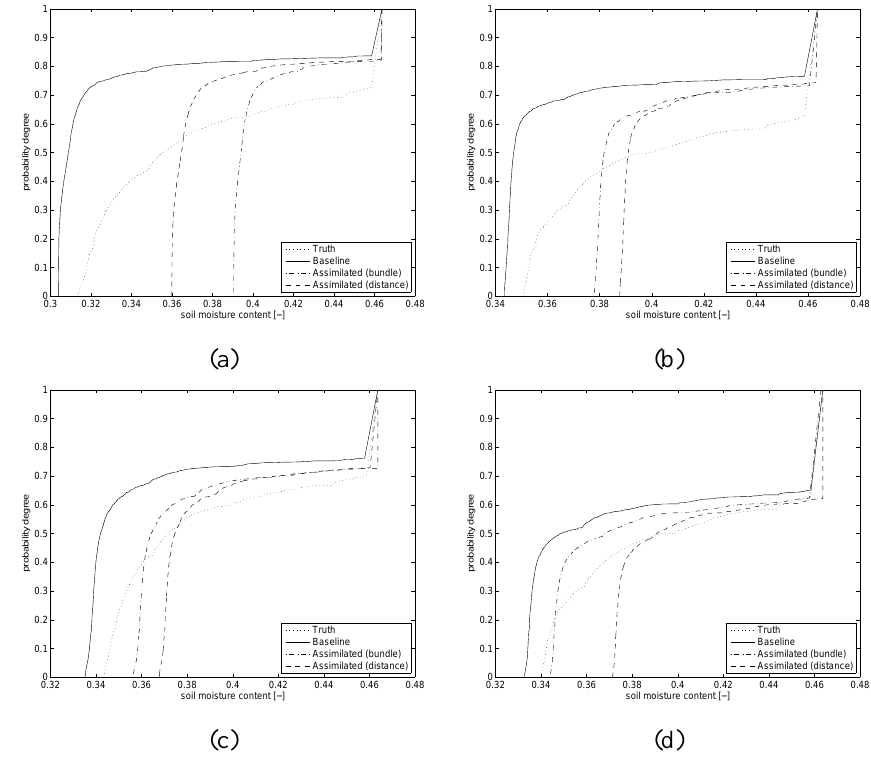
Fig. 10. Cdfs at the different assimilation time steps, (a) at DOY42, (b) at DOY 105, (c) at DOY 117 and (d) at DOY 162. Similarity Index between the updated soil moisture